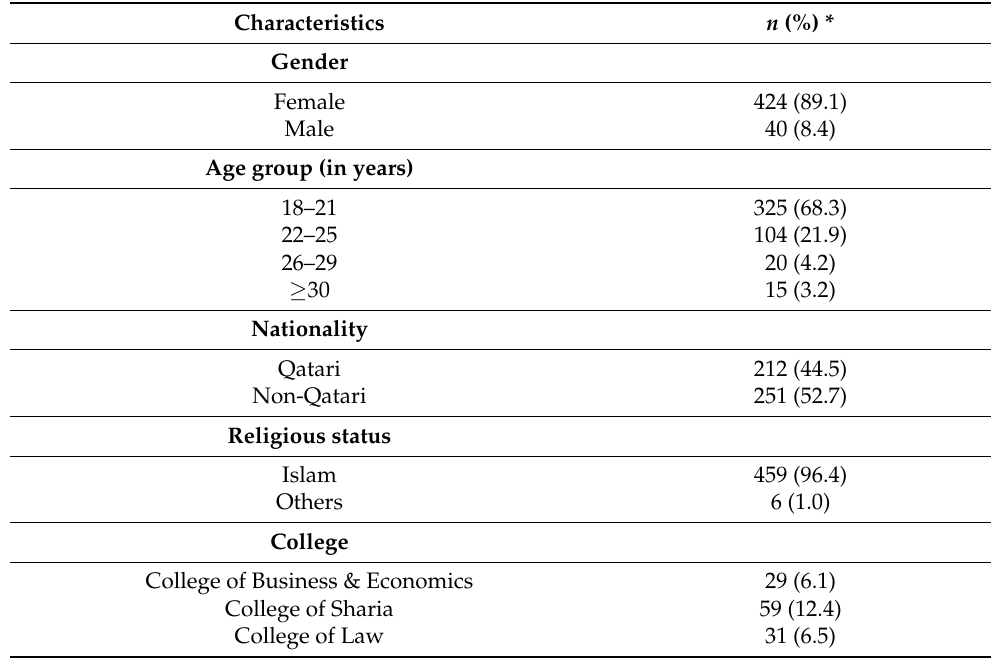
Table 1. Sociodemographic characteristics of the participants (N =